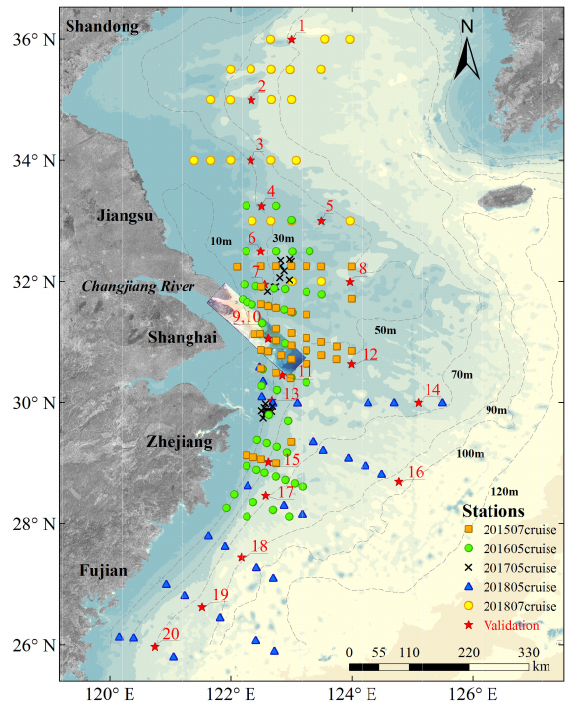
Figure 1. Sampling locations of 183 stations during the five field campaigns from 2015 to 2018, including 163 stations used for the NN TL construction and 20 numbered stations used for validation, and overlaid with the true color Hyperspectral Imager for the Coastal Ocean (HICO) image used in this study (Section 2.3). The color-coded bathymetry data (GEBCO_2014 Grid, version 20150318) was obtained from GEBCO (http: // www.gebco.net / ). Depth contours of 10, 30, 50, 70, 90, 100 and 120 m are sketched by gray dashed